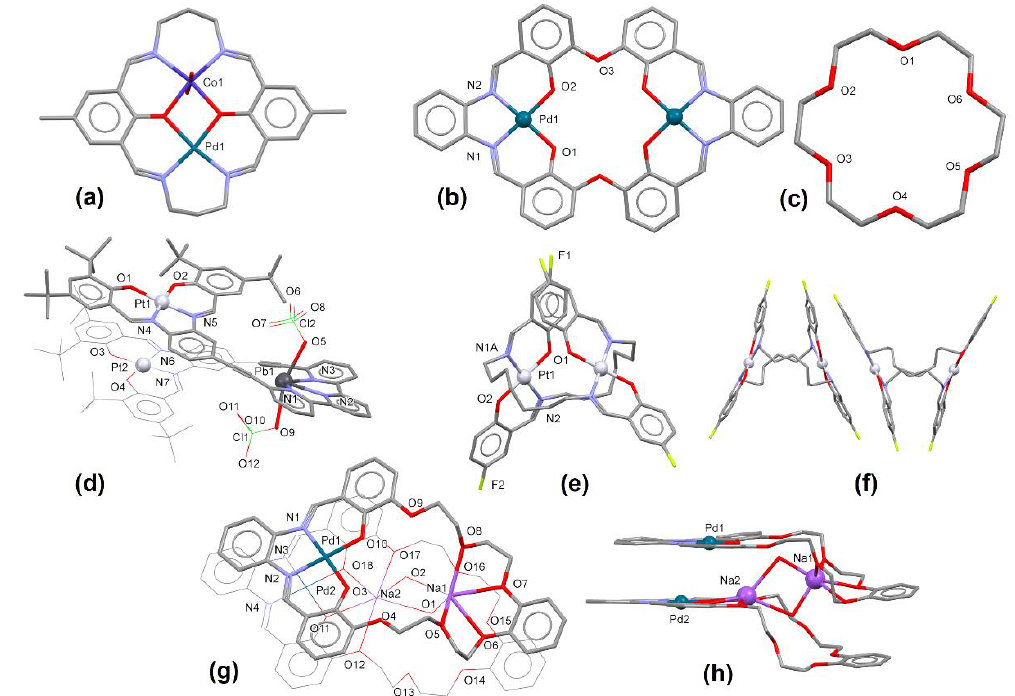
Figure 12. ( a ) A simple example of binuclear coordination compound based on calixsalen — Schiff base macrocycle [45] (CSD Refcode MIKQIJ); ( b ) 18-Crown-6-like binuclear metallohost based on two Pd metallosalen fragments [181] (CSD Refcode FARNIY); ( c ) macrocyclic 18-Crown-6 polyether [182] (CSD Refcode ABULOZ); ( d ) molecular tweezers based on Pt-salphen-terpyridine moiety for selective recognition of divalent cations helically closed on recognition of the Pb 2+ ion [183] (CSD Refcode BORCES); ( e ) one of the symmetrically independent molecules and ( f ) side view at molecules of bis( µ -2,2’-{heptane-1,7-diylbis[azanylylidenemethanylylidene]}bis(4-fluorophenolato))-bi-platinum [184] (CSD Refcode YOLDEL) and ( g ) dimeric tetranuclear complexes of palladium(II) and alkali metal(I) ions based on crown ether-macrocycle with salophen related metallohost ( h ) and a side view [185] (CSD Refcode AYOYOC). Hydrogen atoms, solvent and counterion molecules were omitted for clarity.